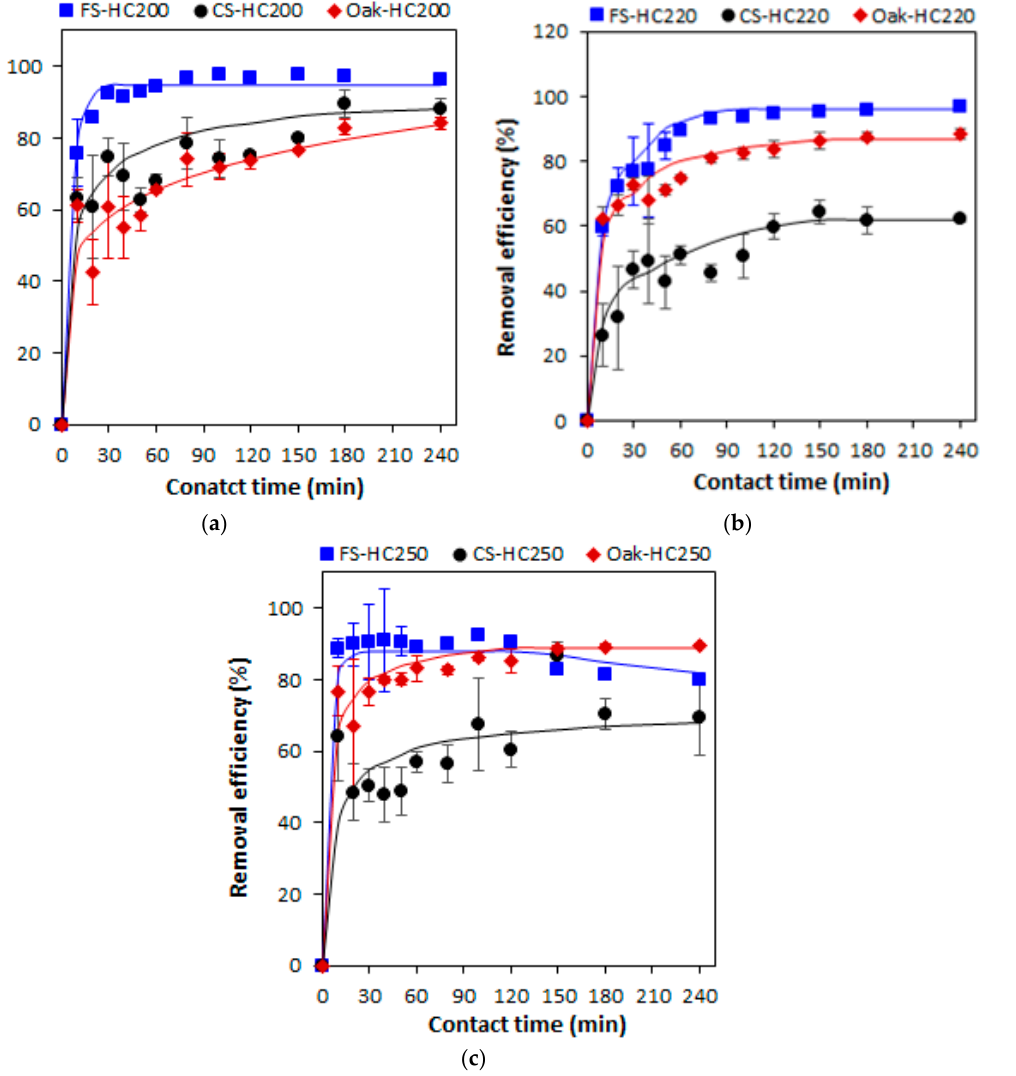
Figure 4. Effect of adsorption contact time and HTC temperature on adsorption removal efficiency of hydrochars derived at ( a ) 200 °C; ( b ) 220 °C; and ( c ) 250 °C. FS-HCs were the best-performing hydrochars, with FS-HC200 removing 97.88% of the MB within 150 min, whilst FS-HC220 and FS-HC250 removed 96.83% and 92.33% of